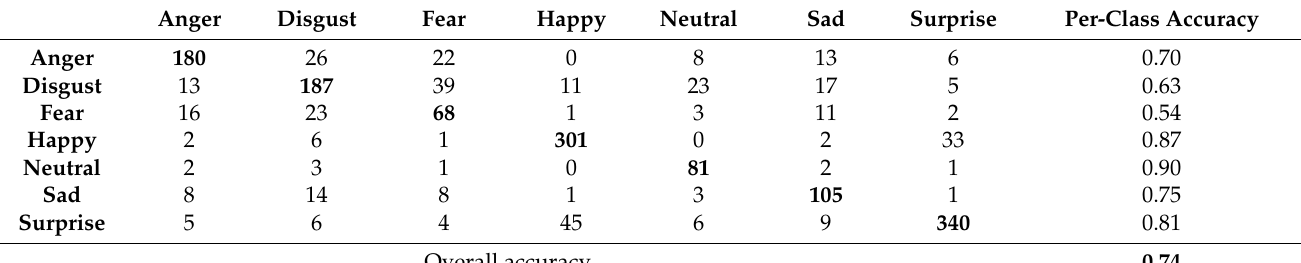
Table 8. Cross-validation over the CK+